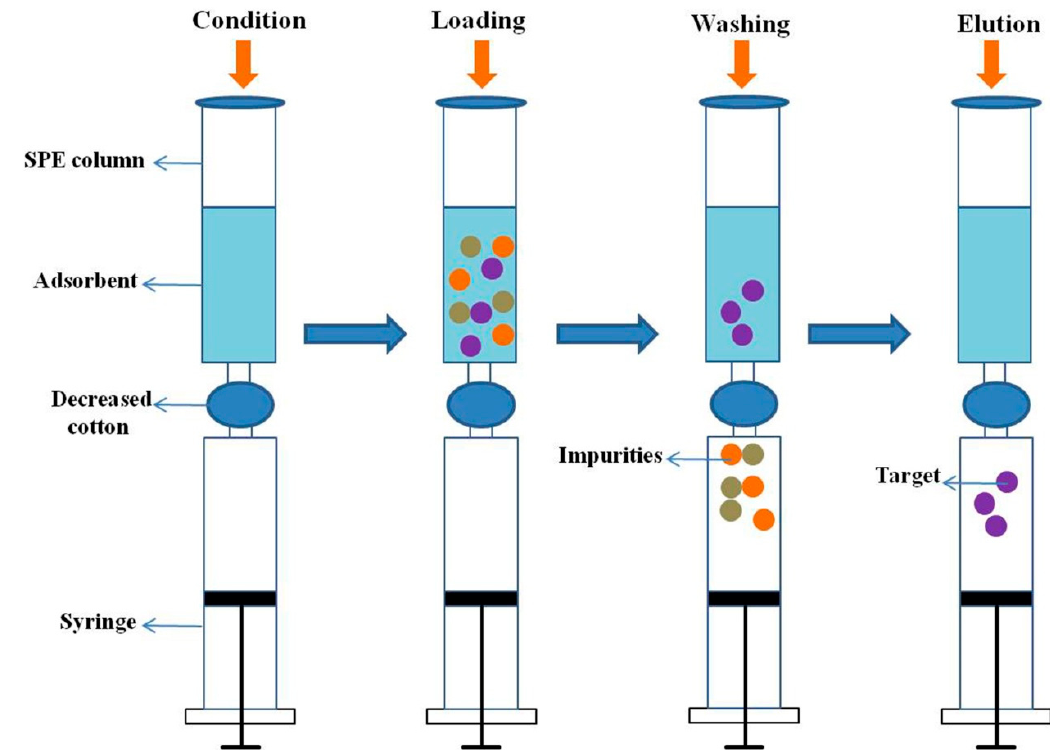
Figure 2. Schematic illustration of the miniature solid phase microextraction (SPME) procedure.